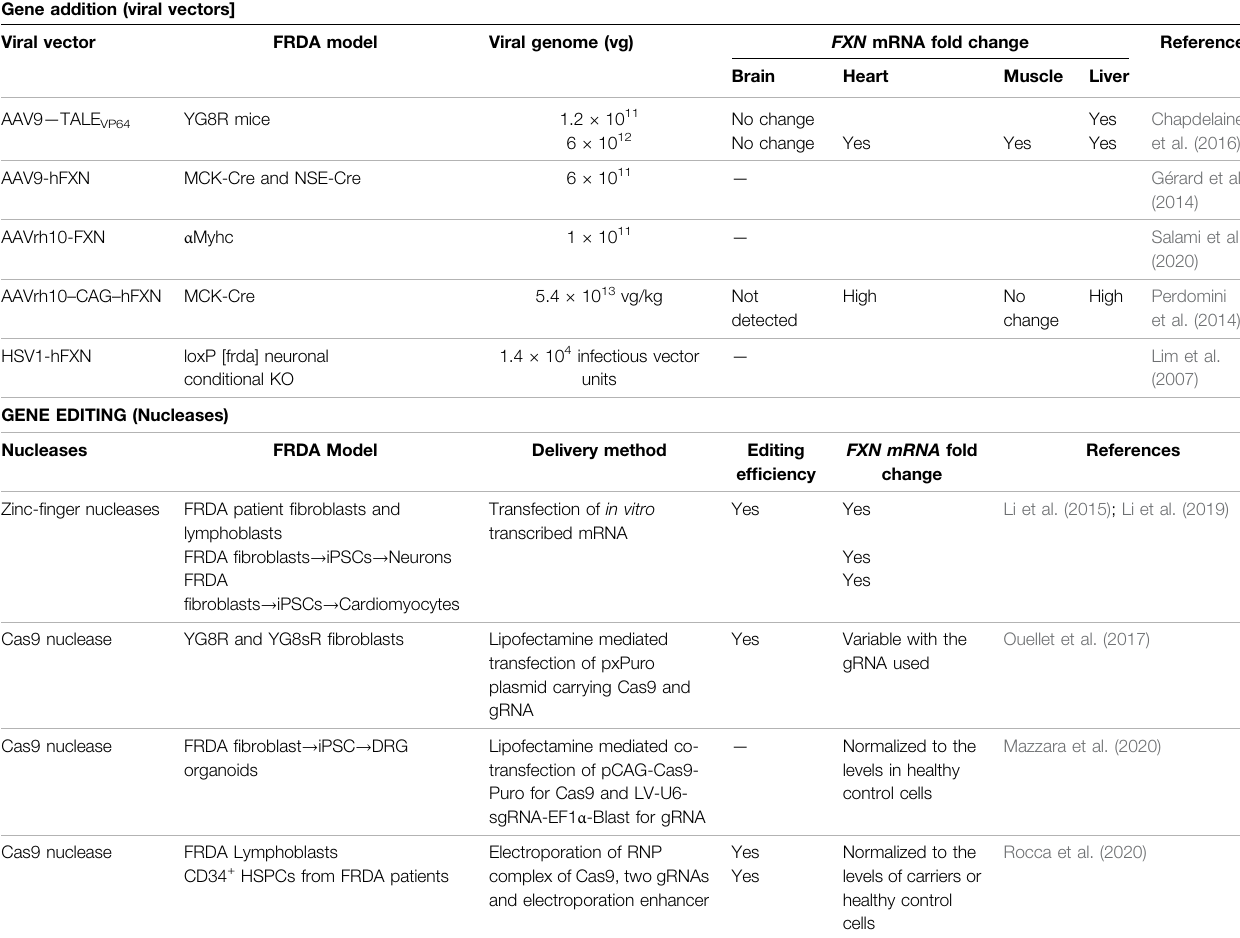
TABLE 1 | Feasibility of gene therapy methods in increasing FXN expression, in vitro and in vivo . Gene addition (viral